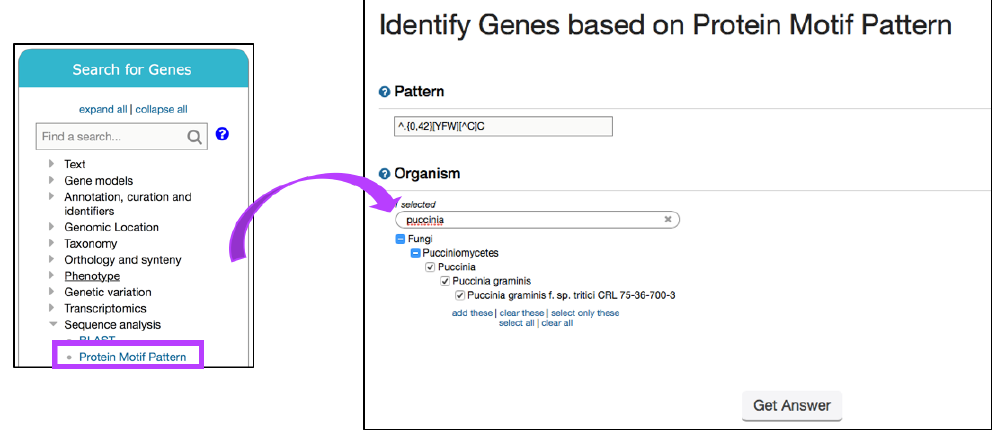
Figure 15. Identifying genes via the Motif Pattern tool. Shown is a search for the effector protein motif in P. gramminis using a regular expression (Step 1). Strategy in FungiDB: http://fungidb.org/fungidb/